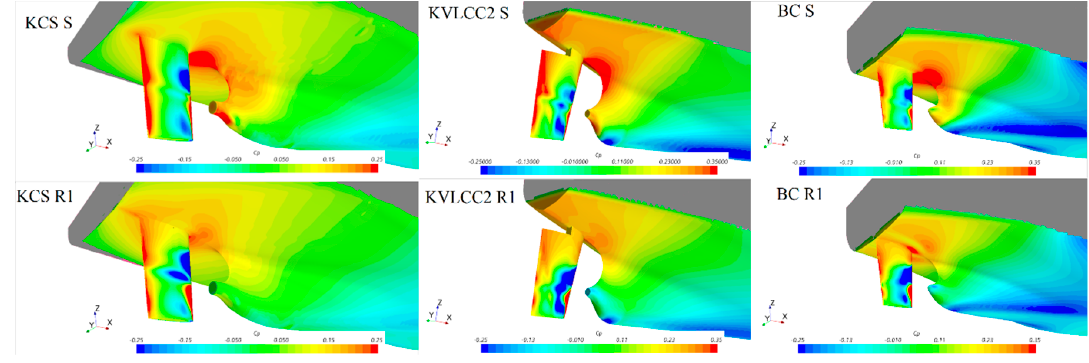
C distribution for the area near the stern. Figure 19. The impact of hard fouling on P Figure 19. The impact of hard fouling on C P distribution for the area near the